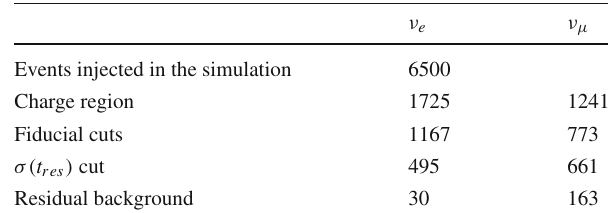
Table 1 Summary of selections flow for ν e and ν μ fluxes, in terms of numberofeventsintheanalysisregion,appliedtothesmalldatasample correspondingto ∼ 5yearsofdatataking.Thevaluesarereportedbefore the selections, after the fiducial cuts and after the σ( t res ) selection. The residual background is also